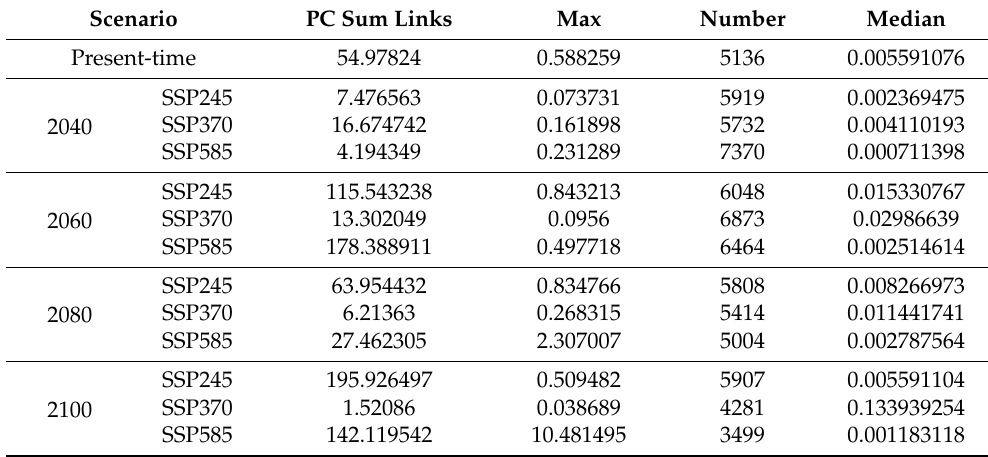
Table 3. Variation in the importance of connectors with the 80–100% distribution.